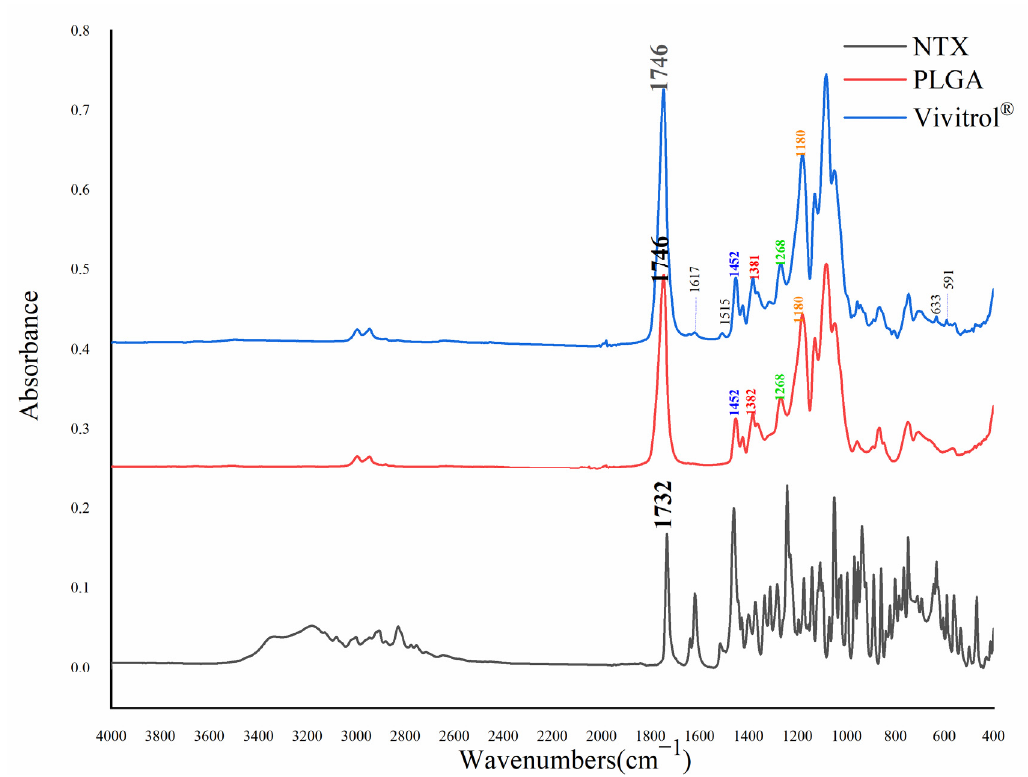
Figure 8. Infra-red spectra of NTX, PLGA and Vivitrol ®.